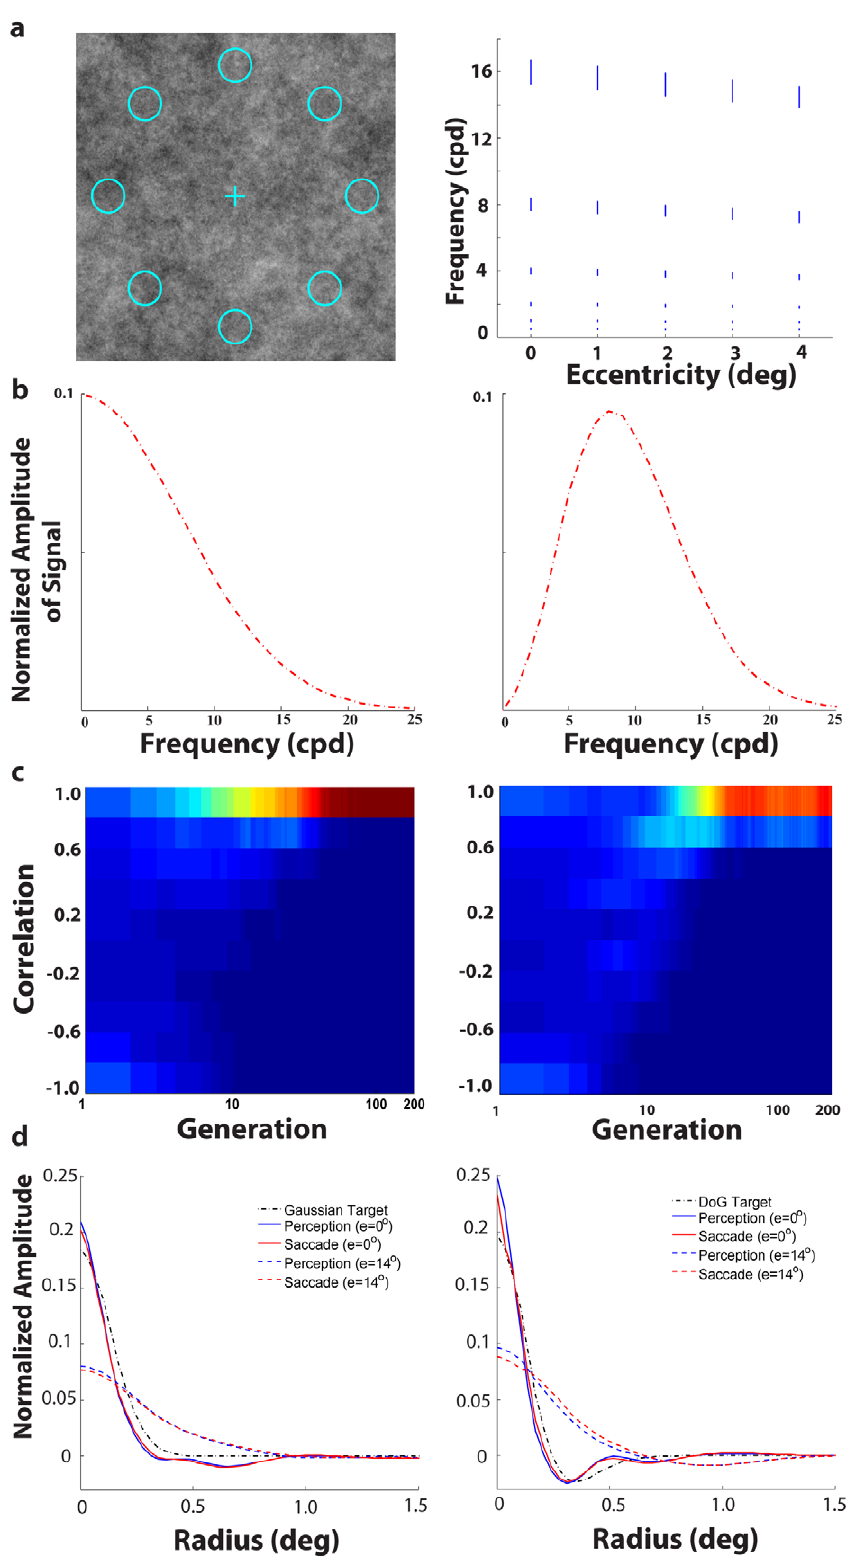
Figure 5. Evolution plots for a model with changing V1 receptive field size/spatial frequency with retinal eccentricity. a. 8 AFC search task in 1/f noise (left) and graph (right) showing the change in central spatial frequency and width of channel in the frequency domain of oriented Gabor functions with retinal eccentricity. b. Radial profiles in the frequency domain of Gaussian target (left) and DoG target (right) with a center frequency of 8 cycles/degree. c. Distribution of correlations between perception and saccade templates of individuals in each generation for Gaussian